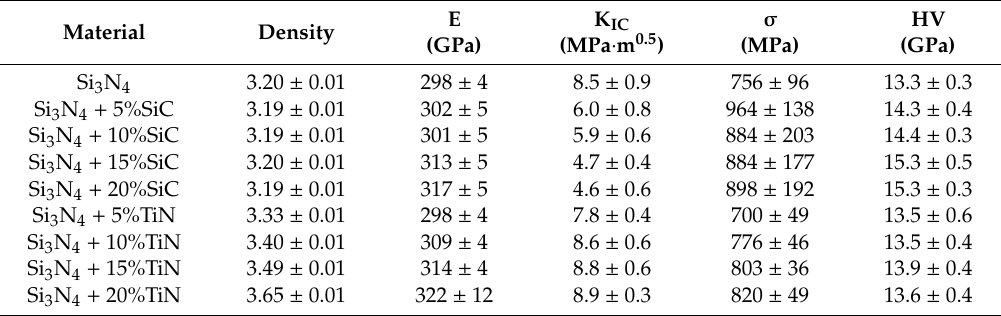
Table 4. Density and elastic and mechanical properties of polycrystalline silicon nitride